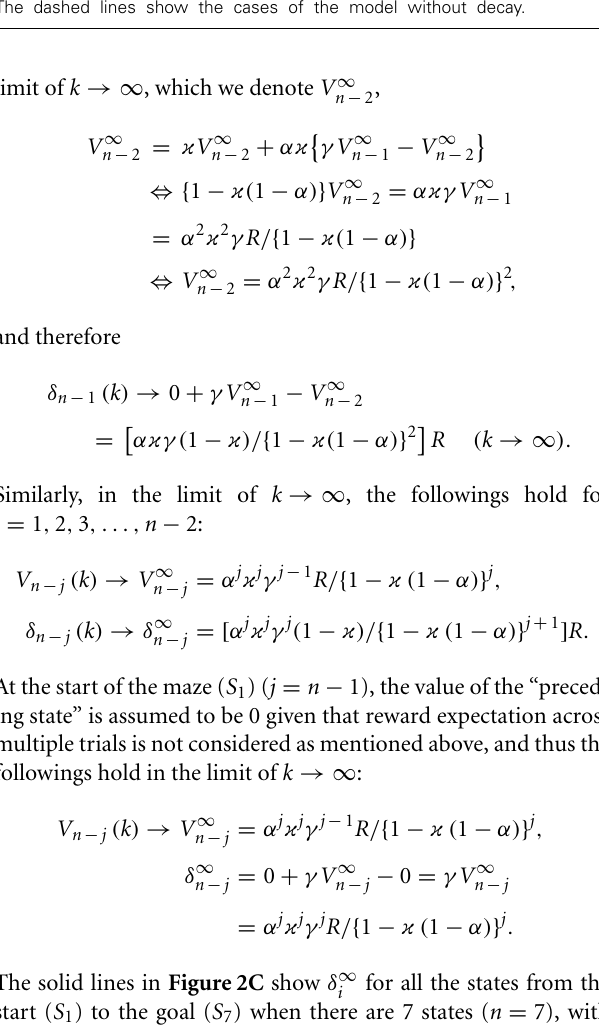
(C) The solid lines show the eventual (asymptotic) values of RPE after the convergence of learning at all the states from the start ( S 1 ) to the goal ( S 7 ) when there are 7 states ( n = 7) in the model incorporating the decay, with varying (a) the learning rate ( α ), (b) the time discount factor ( γ ), (c) the decay factor ( (cid:5) ), or (d) the amount of the reward obtained at the goal ( R ) [unvaried parameters in each panel were set to the middle values (i.e., α = 0 . 6, γ = 0 . 8 ( 1 / 6 ) , (cid:5) = 0 . 75, and R = 1)]. The dashed lines show the cases of the model without decay.